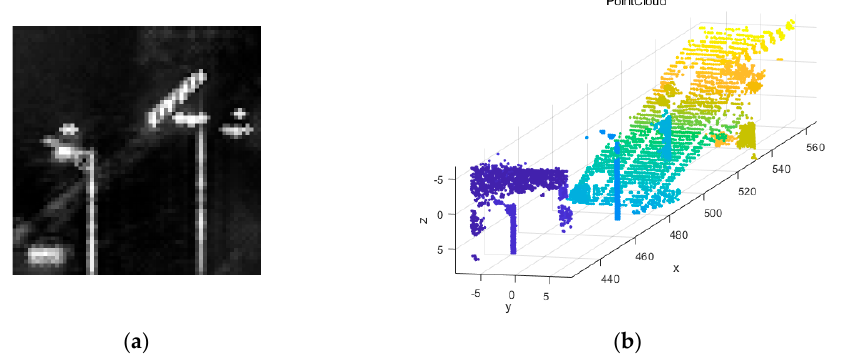
Figure 1. Lidar data. ( a ) Intensity image; ( b ) point cloud data.